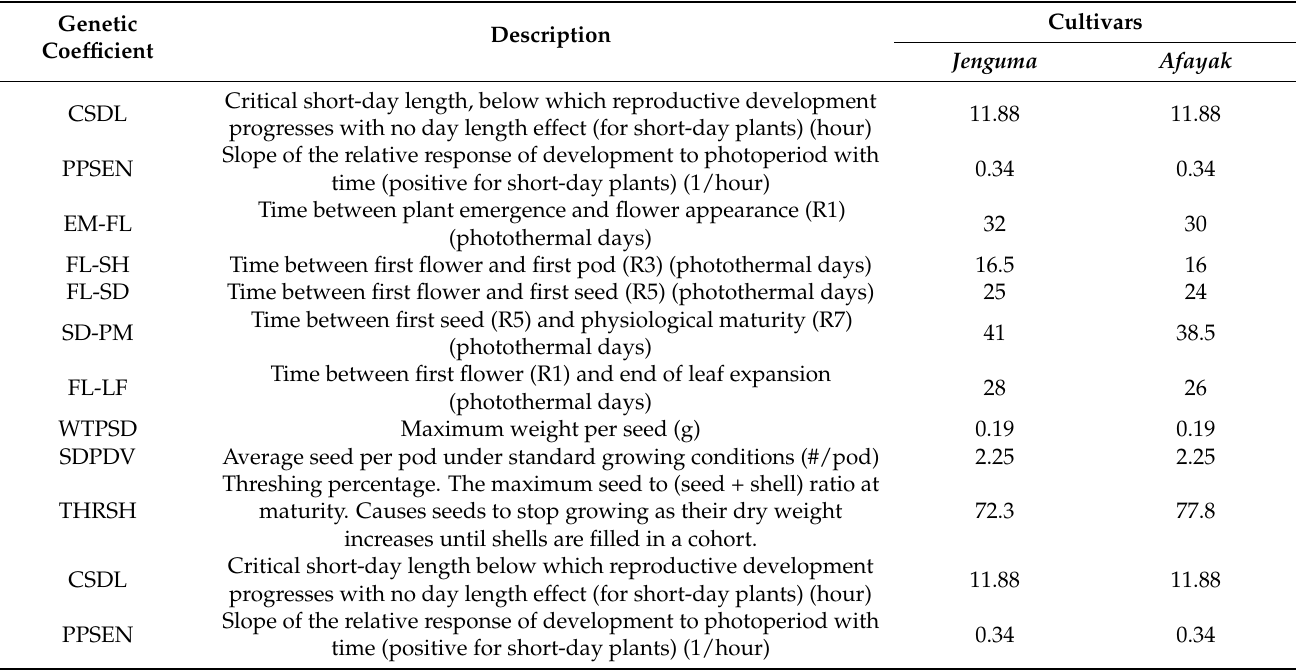
Table 2. Genetic coefficients of the soybean varieties